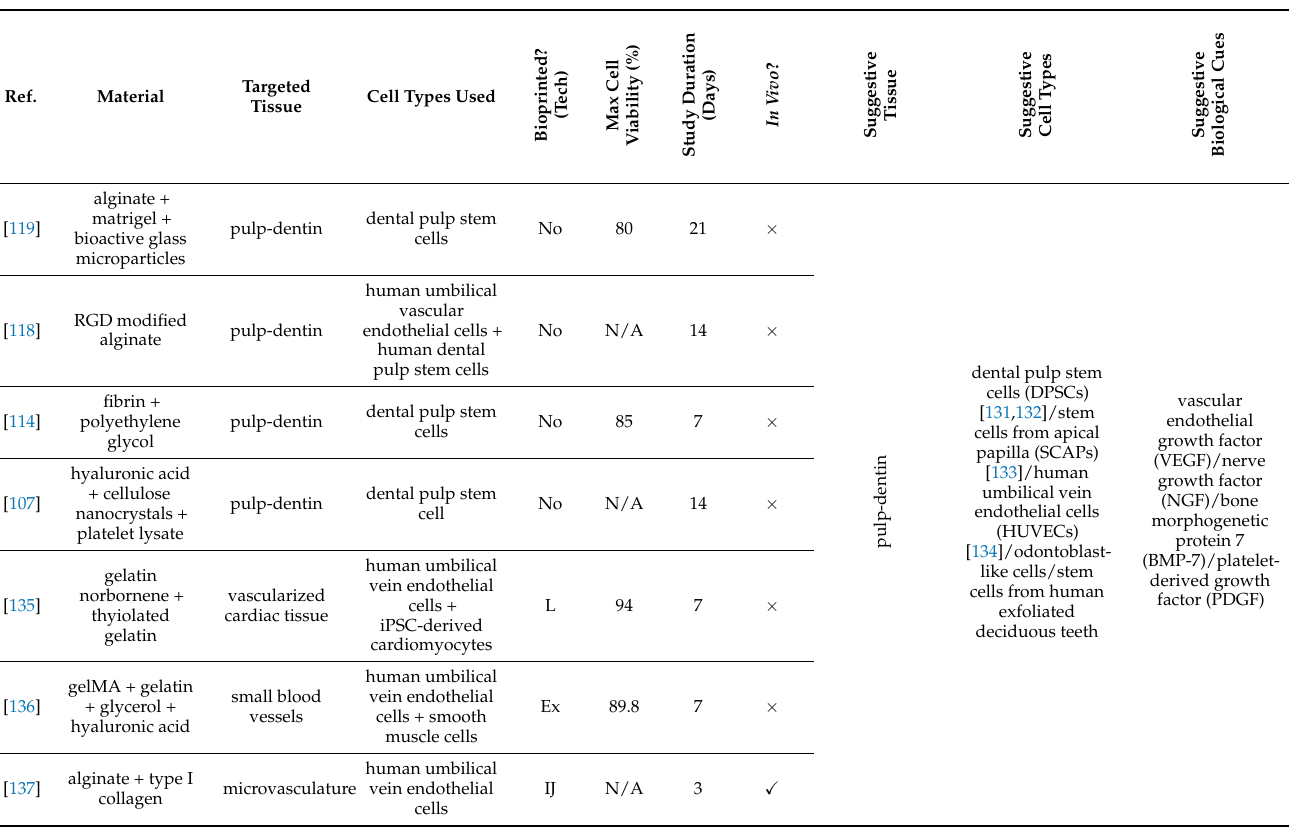
Table 2. An overview of some candidate materials with potential to be used in bioprinting for pulp-dentin, along with cell types and biological cues useful for the purpose. (IJ: inkjet, EX: extrusion. L: laser based).